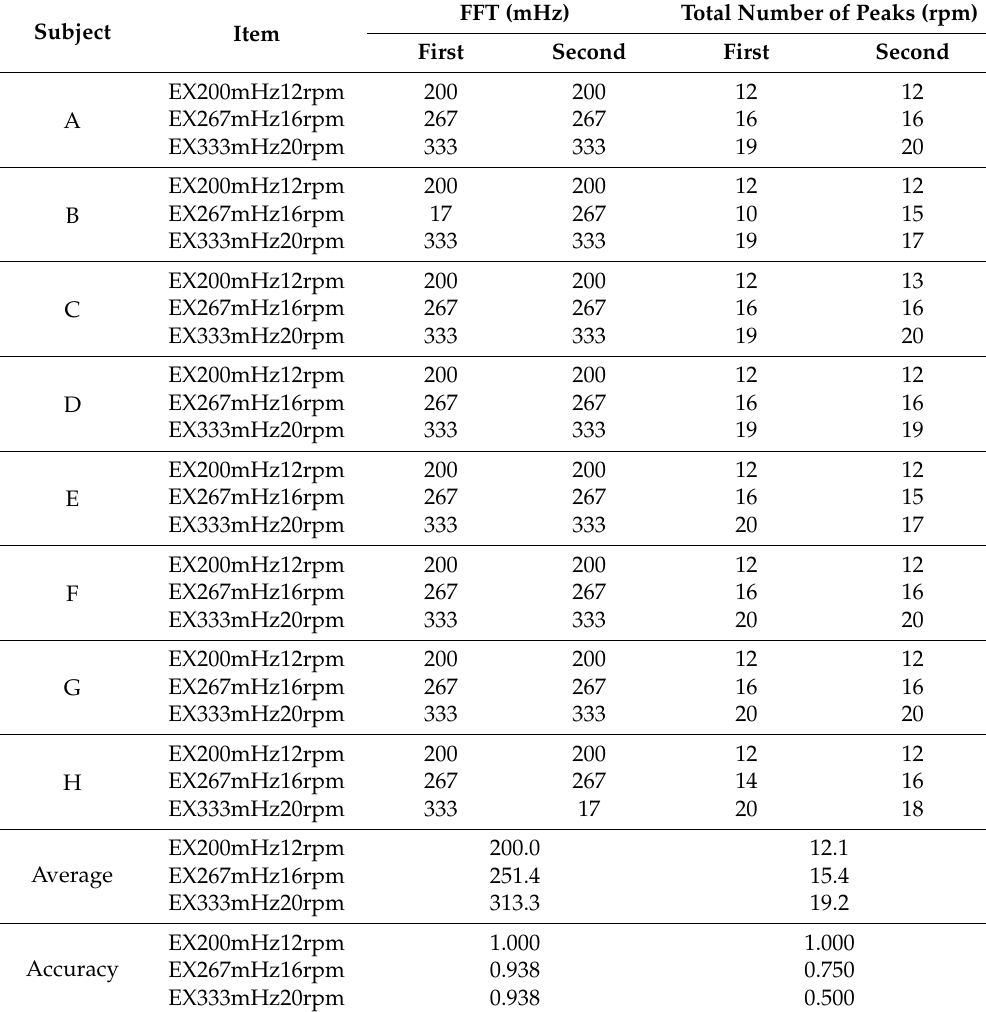
Table 1. Evaluation experiment results for the eight subjects. Item represents the content of experiment. The next column, fast Fourier transform (FFT) (mHz), indicates the frequency at which the FFT power spectrum was maximum in the Item experiment. This frequency corresponds to the calculated value of the respiratory frequency (calculated by the earable POCER). Finally, as a reference value, we obtained the wave number (number of peaks) through zero-crossing detection from the values used in FFT analysis. This is the reference value for the respiratory